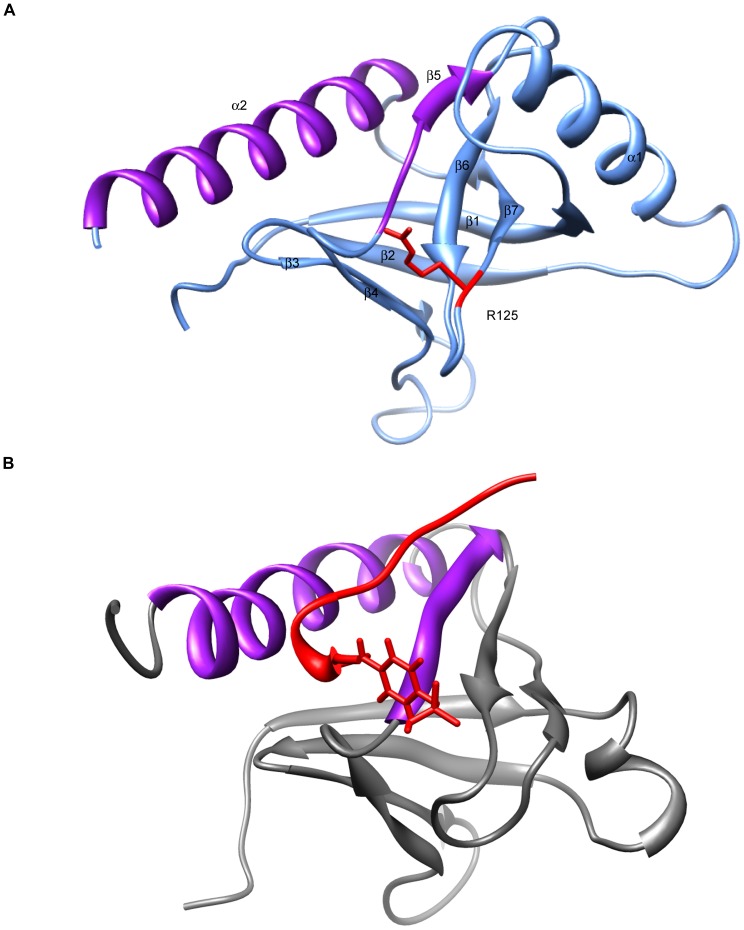
Location of R125 in the homology model of human TBC1D1 PTB1.(A) Homology based model of TBC1D1 PTB domain (residues 13–161) predicted by Robetta server (http://robetta.bakerlab.org/). The R125 residue (red) is orientated towards the cleft formed between β5 and α2 (purple). (B) Solved structure of IRS-1 PTB domain (PDB ID: 1IRS, [47]). The IL-4 phosphopeptide (red) lies within the cleft formed between the β5 and α2 (purple), a type I β turn redirects the peptide such that the phosphorylated Tyr (shown) is orientated towards the β6/β7 loop.